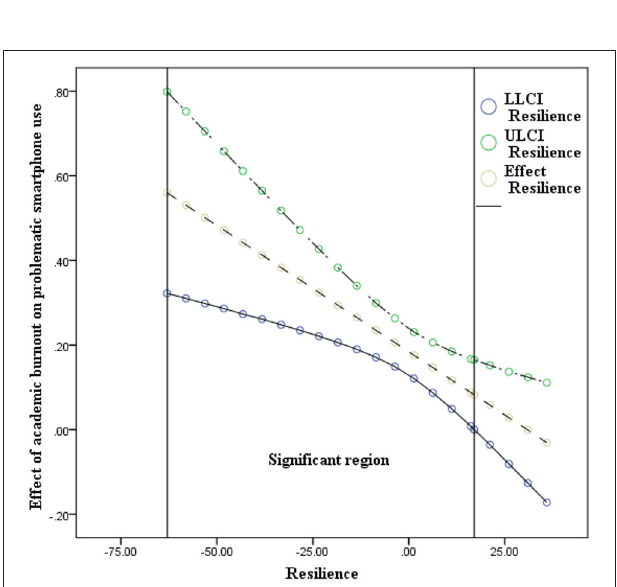
FIGURE 5 | Effects of resilience with 95% confidence interval ( N = 748). LL, low limit; CI, confidence interval; UL, upper limit. The Johnson-Neyman (J-N) method was applied to measure the significant region in which resilience significantly moderated the impact of academic burnout on problematic smartphone use. The upper and lower lines indicated the limits of confidence interval and the middle line indicated the effect of resilience. The scores of statistical significance ranged from − 63.027 to